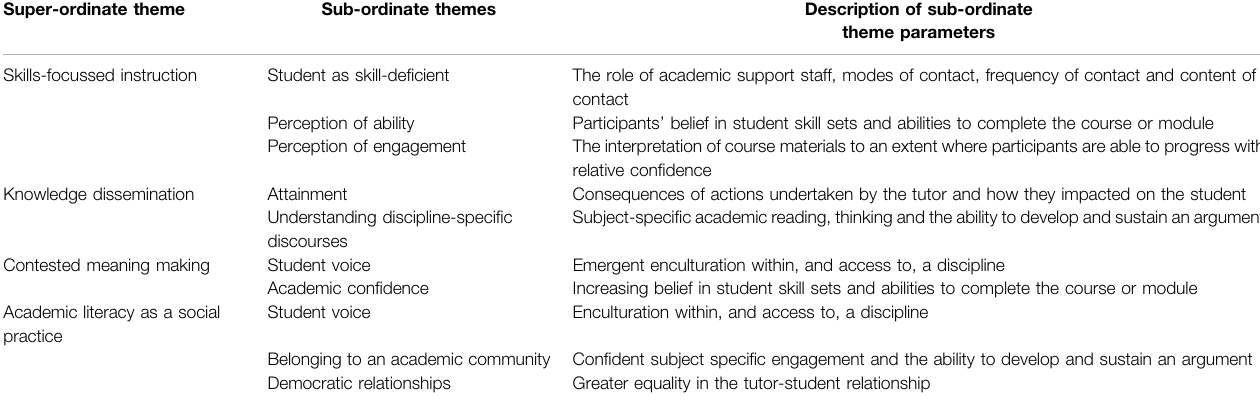
TABLE 1 | Super-ordinate and Sub-ordinate themes.